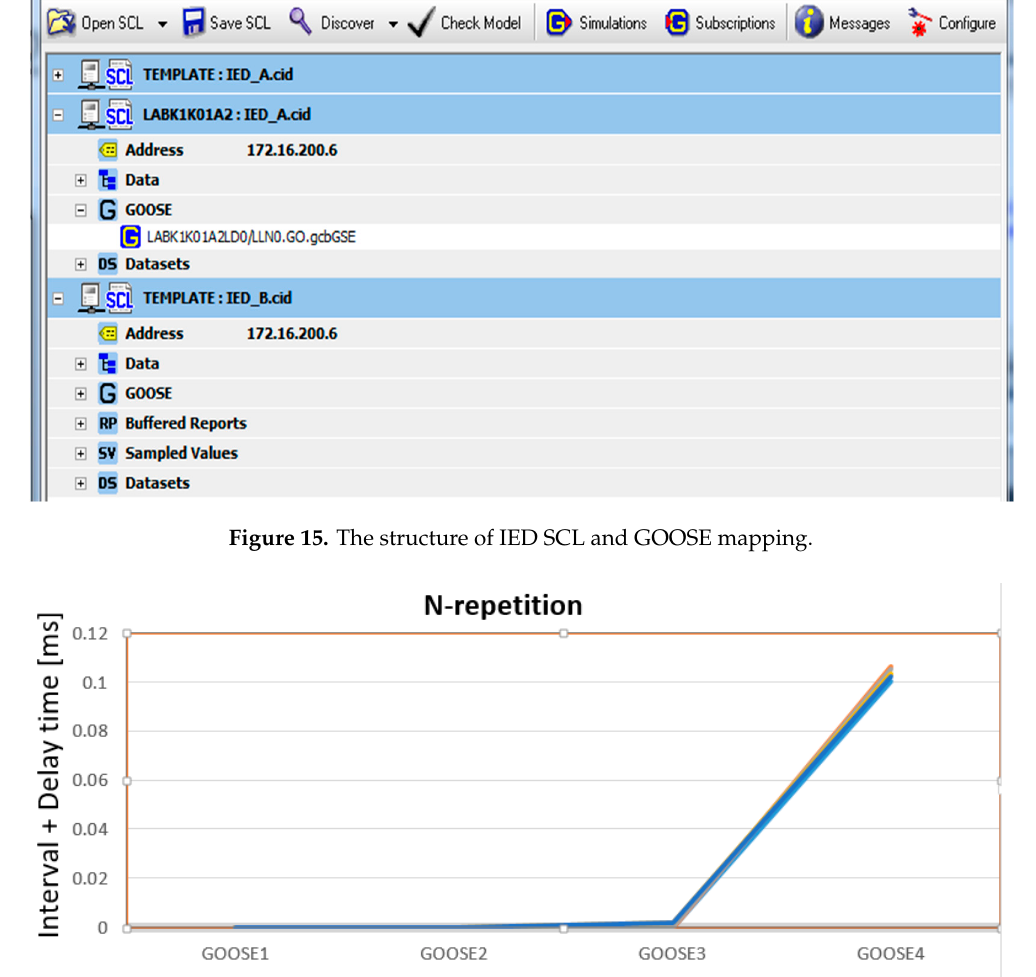
Figure 16. GOOSE Messages duplicities for five different GOOSE messages. n-repetition.